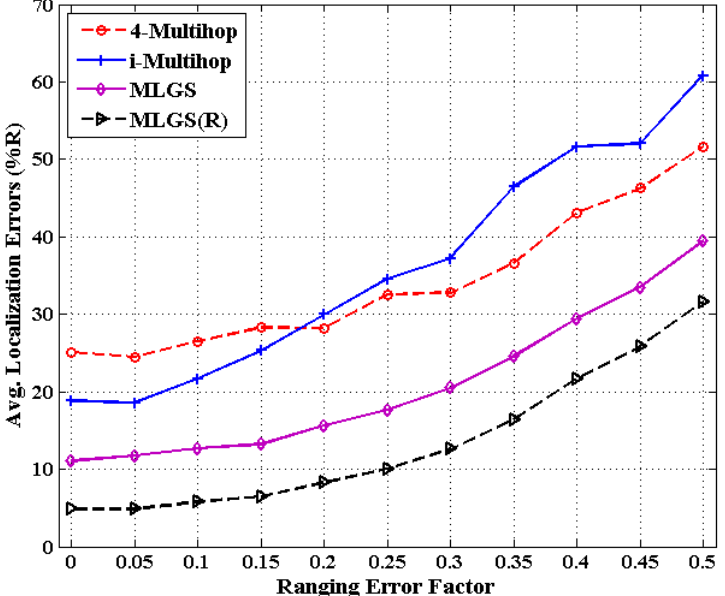
Figure 17. Average localization error versus ranging error factor (anisotropic